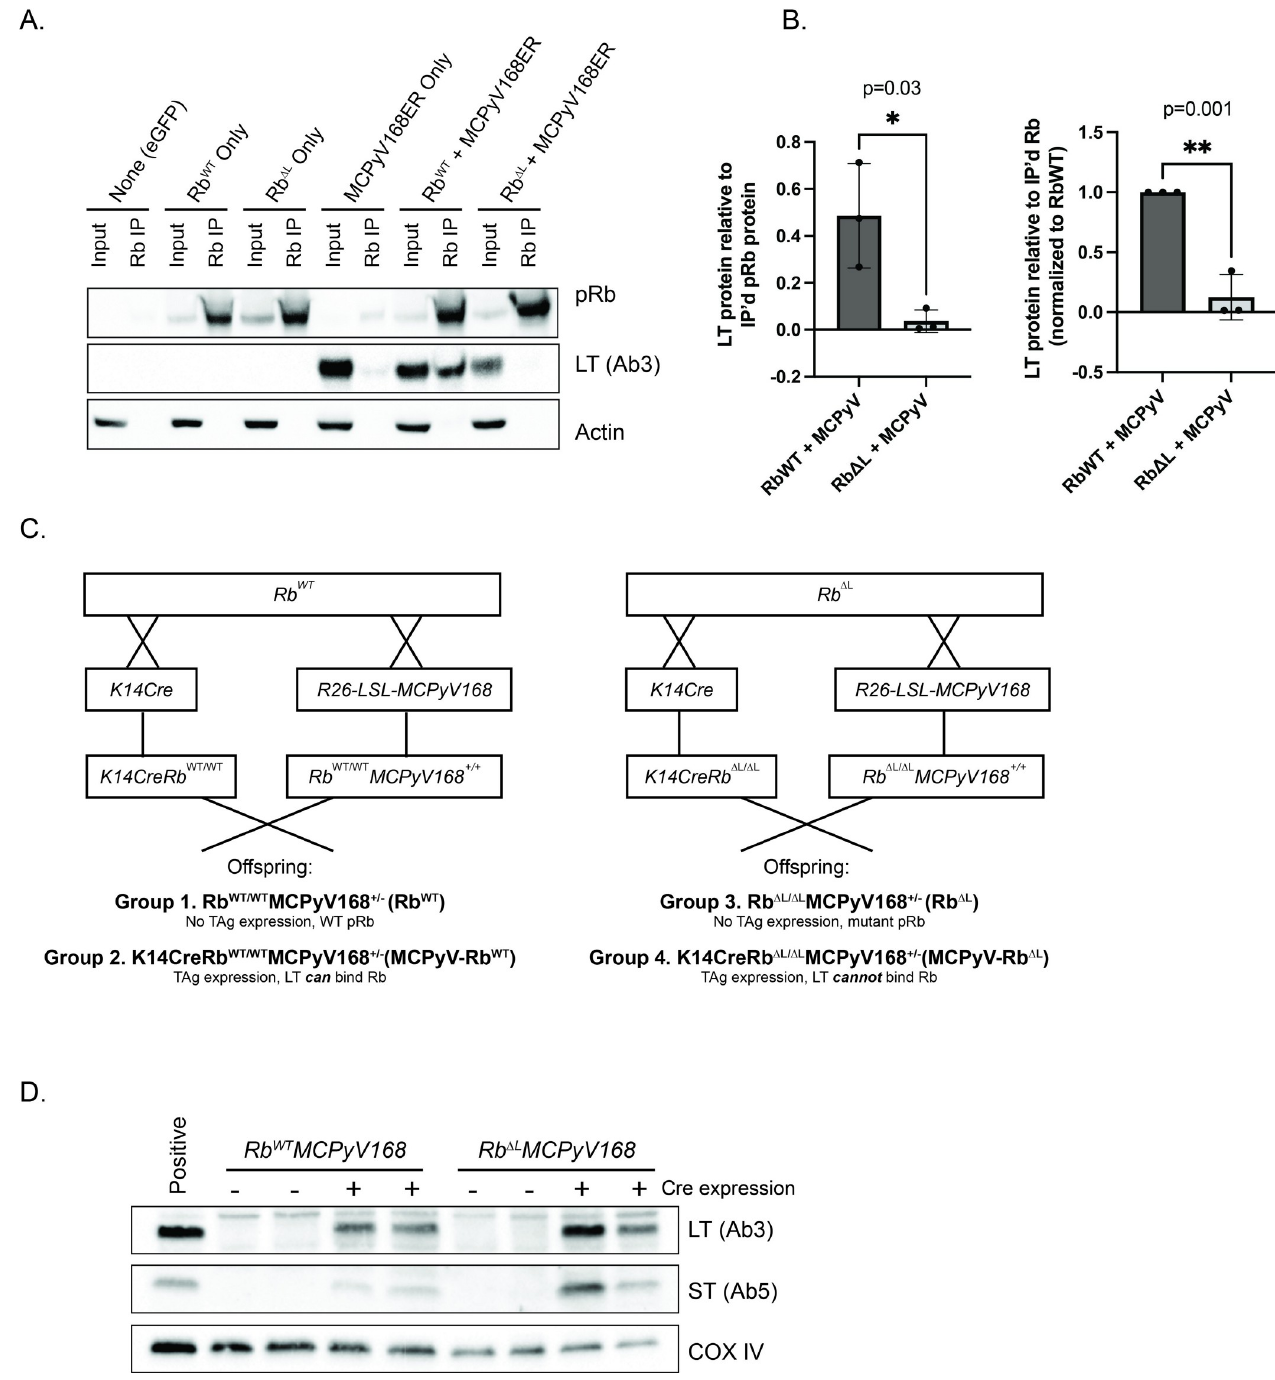
Fig 1. The Rb Δ L mutation in pRb disrupts its interaction with MCPyV LT but does not affect K14-directed expression of MCPyV T antigens in the skin of mice. A) Co-immunoprecipitation and immunoblot analysis of the MCPyV large T antigen (LT) and pRb. 293FT cells were transfected with pcDNA-dsRed plasmid (none), pRb WT only, pRb Δ L only, a MCPyV-168ER expression construct expressing the MCPyV168 early region only, or co-transfected with pRb WT + MCPyV168ER or pRb Δ L + MCPyV168ER. At 48 hours post-transfection, whole cell lysates were collected. Using an anti-pRb antibody, the pRb protein was immunoprecipitated from a total of 1 mg of total protein lysate. Pre-cleared lysate corresponding to approximately 3% (30 μ g) of that used in the immunoprecipitation assay was used as an input control. The input controls and immunoprecipitated complexes were then analyzed by western blotting for pRb (top), the MCPyV LT antigen (middle; Ab3 antibody) and β -actin as a loading control. B) Quantitation of co-immunoprecipitated MCPyV LT protein normalized to the amount of immunoprecipitated pRb protein. Three independent replicates of pRb immunoprecipitation followed by pRb and MCPyV LT